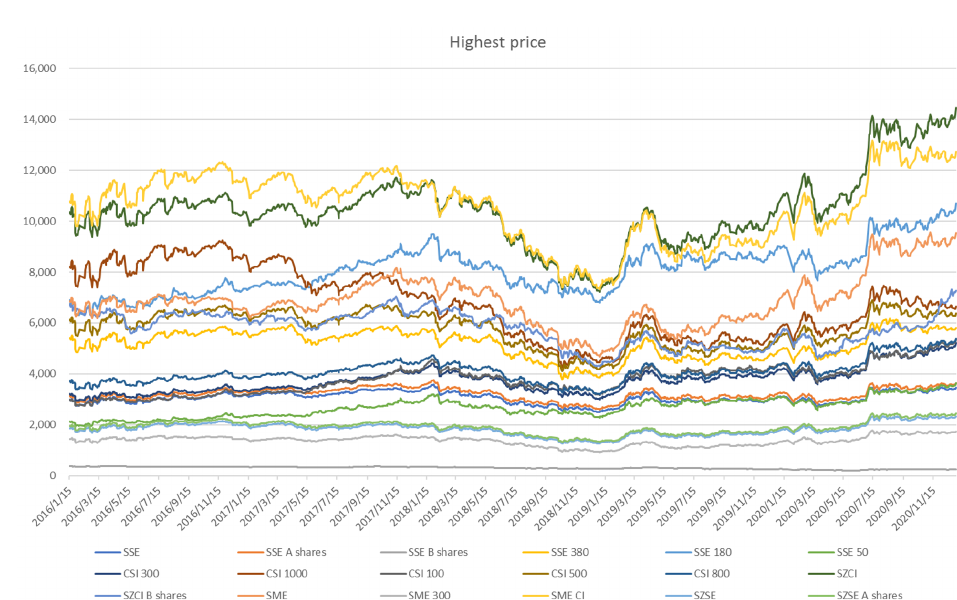
Figure A3. History of highest price in 18 Chinese stock